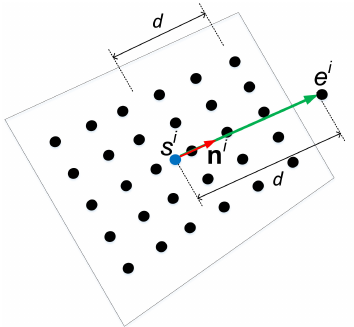
Figure 7. Directed line segment representation of normal vector used in this